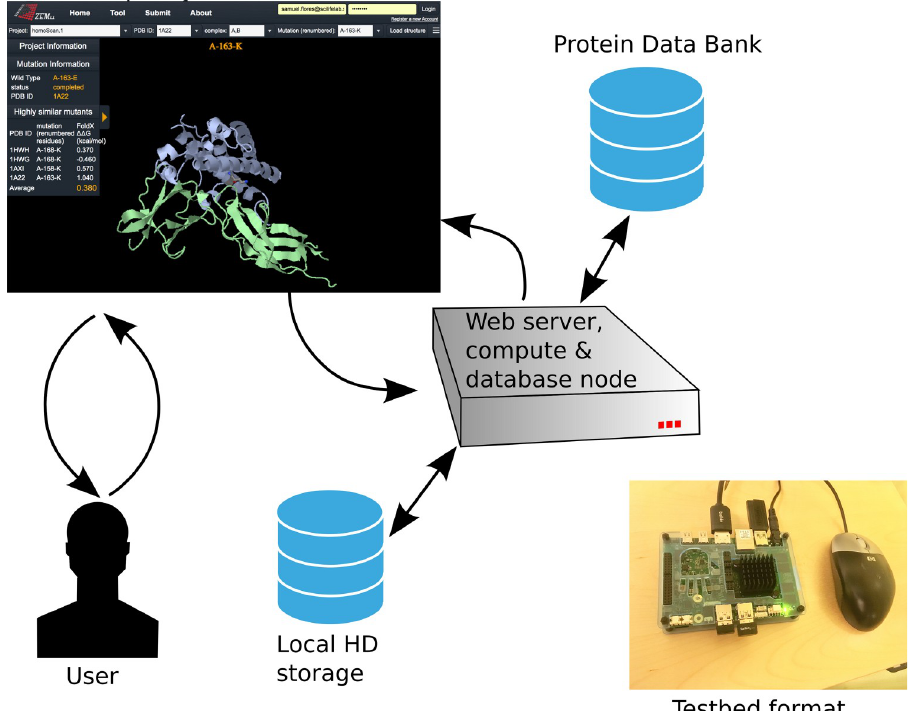
Fig 6. The homologyScanner public web server. Users can provide PDB ID, chose chains in each of two subunits, and specify a mutation to be computed. FoldX ΔΔ G is computed for the query and all matching complexes and reported to the user. The results are available for browsing by others. Compute nodes are needed only for high- throughput runs. The software components are available on github, simtk.org, and dockerhub. A server has also been set up on a single-board computer for private